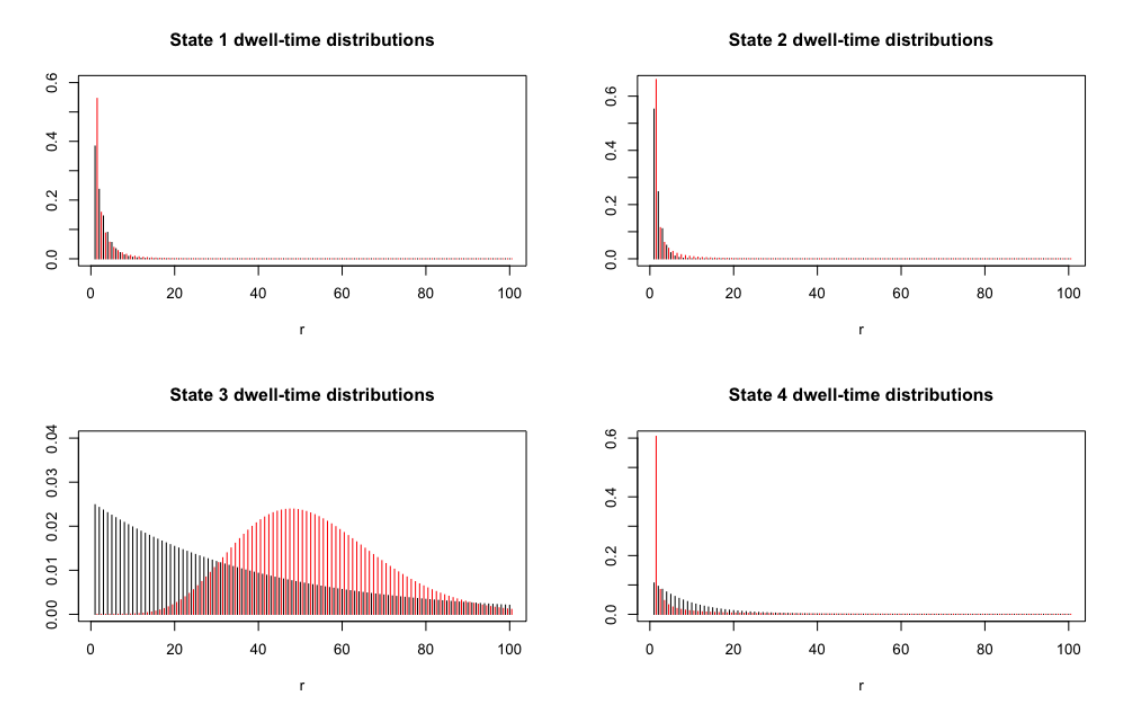
Figure 2. State dwell-time distributions for the homogeneous four-state normal-HSMM (red) and for the stationary four-state normal-HMM (black). Figure reproduced from